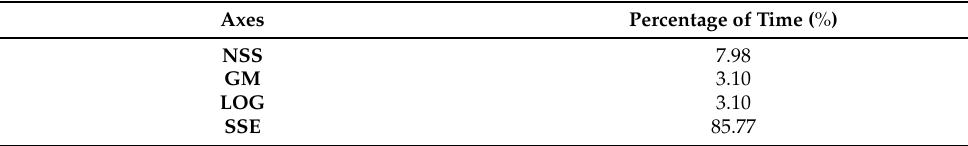
Table 9. Percentage of time consumed by each feature extraction axes.